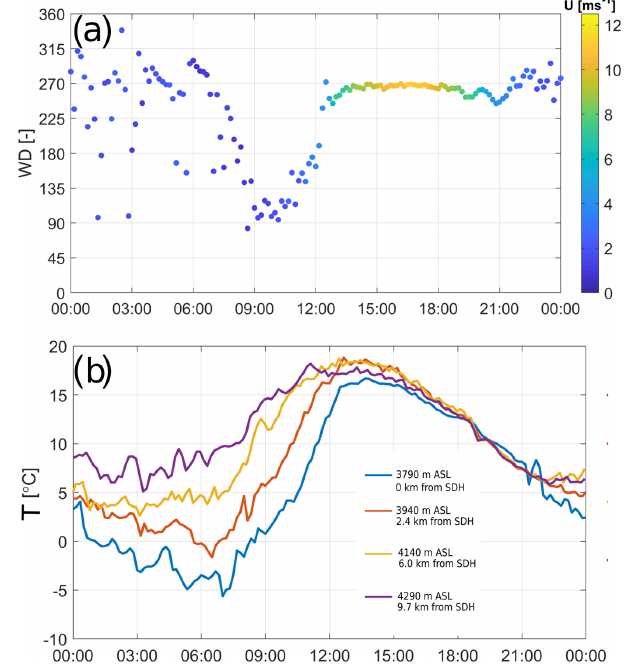
Figure 6. (a) Transect average of wind direction (WD) and wind speed ( U ) for the E-DATA on 21 November 2018. (b) The air tem- perature of the MET station transect shown in Fig. 2b on 21 Novem- ber